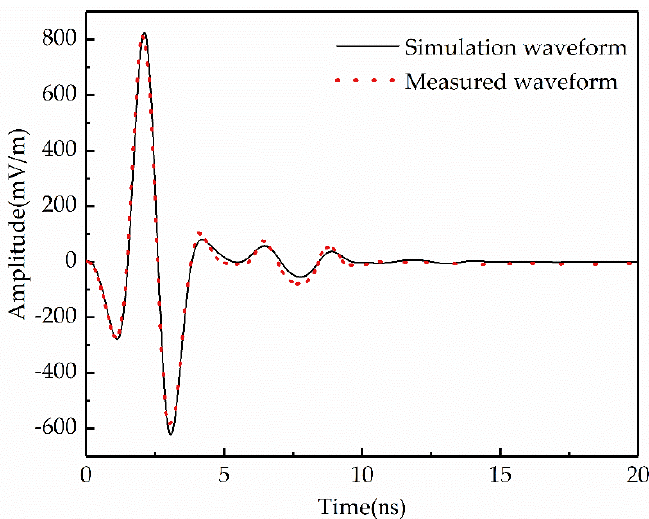
Figure 20. Single−channel wave comparison diagram of simulated and measured results. Figure 20. Single − channel wave comparison diagram of simulated and measured